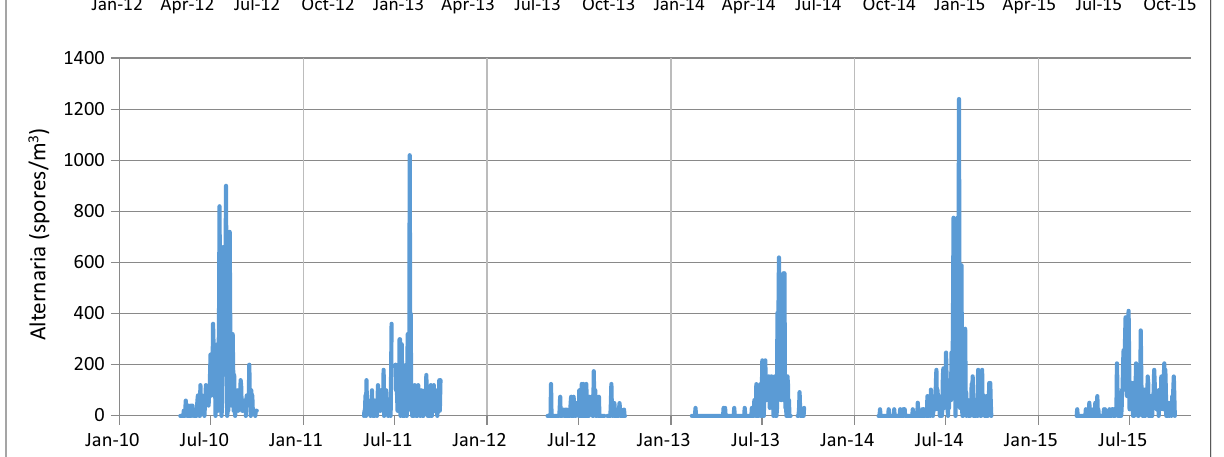
Fig. 1 Aspergillus–Penicillium and Alternaria sporulation from 2010 to 2015